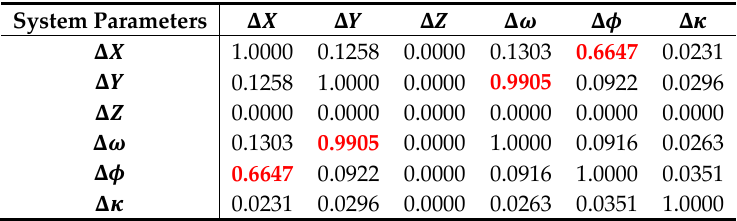
Table 3. Correlation matrix of mounting parameter estimates from calibration test 1 (the potential high correlation values are shown in red).